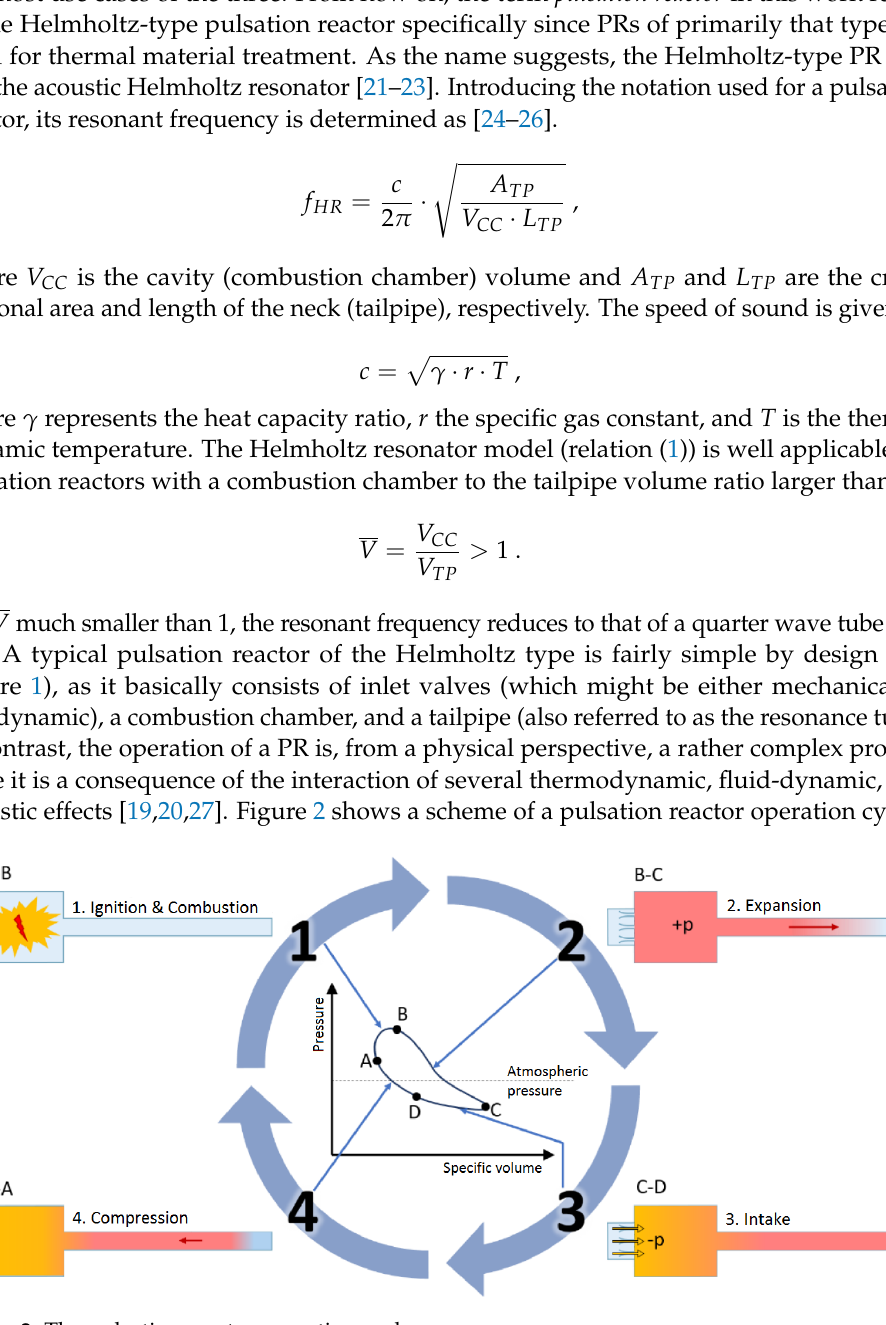
Figure 2. The pulsation reactor operation